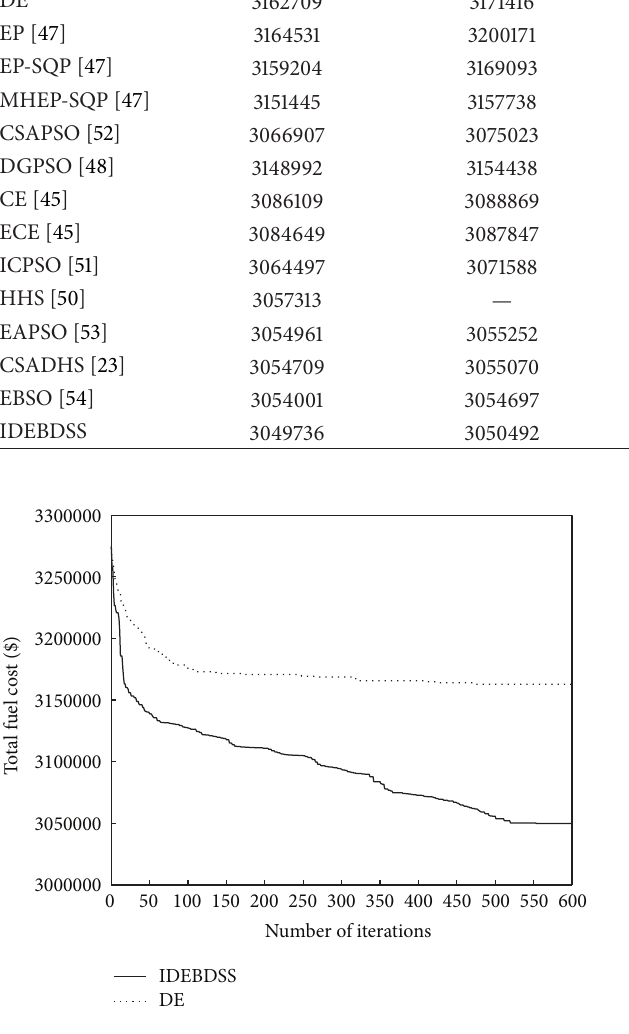
Figure 4: Convergence process of the best solution obtained by IDEBDSS and DE methods for test system 3.